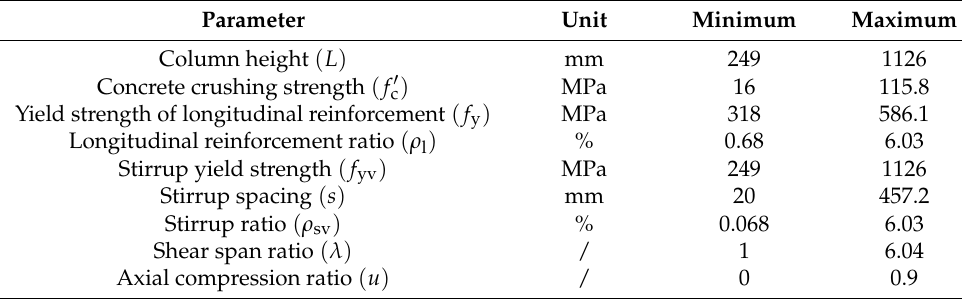
Table 1. Ranges of parameters in sample